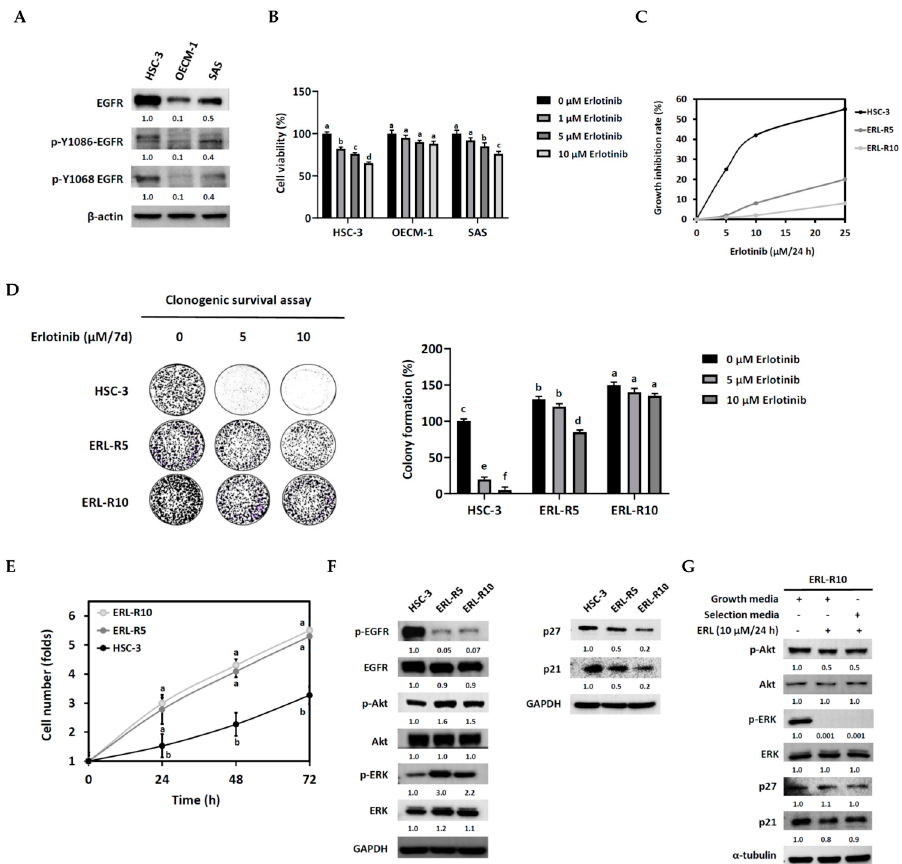
Figure 1. Establishment of erlotinib-resistant oral cancer cell lines. HSC-3, OECM-1, and SAS cells were cultured to 80% confluence, and ( A ) cell lysates were subjected to Western blot analysis to detect the protein levels of EGFR and p-EGFR. β -actin served as an internal control, and each protein expression level was quantified as a relative number to that of HSC-3 cells. ( B ) HSC-3, OECM-1, and SAS cells were cultured with or without erlotinib for 24 h, followed by an MTT cell viability assay. Each bar represented a cell number as a percentage of the control (0 µ M erlotinib). Values are mean ± SD, n = 3. abcd Values without the same letter differ significantly, p < 0.05. ( C – G ) Assessment of erlotinib-resistant cell lines. ( C ) HSC-3, ERL-R5, and ERL-R10 cells were cultured with erlotinib (0, 5, 10, 25 µ M) for 24 h and viable cell number was determined by an MTT assay. Data were expressed as growth inhibition rate relative to the control (0 µ M erlotinib). ( D ) HSC-3, ERL-R5, and ERL-R10 cells (2 × 10 3 cells) were seeded onto a 6-well plate and cultured with erlotinib (0, 5, 10 µ M) for 7 days and stained with 0.5% crystal violate. Each bar represented colony formation as a percentage of the control (0 µ M erlotinib). Values are mean ± SD, n = 3. abcdef Values with different letter differ significantly, p < 0.05. ( E ) HSC-3, ERL-R5, and ERL-R10 cells (1.5 × 10 4 cells) were cultured in 3-cm dishes for 24 h and viable cell number was determined by an MTT assay. Values are mean ± SD, n = 3. ab Values with different letter differ significantly at indicated time point, p < 0.05. ( F ) Cell lysates from HSC-3, ERL-R5, and ERL-R10 cells with 80% confluence were subjected to Western blot analysis for indicated proteins. ( G ) ERL-10 cells were cultured in growth media with or without erlotinib or in selection media to 80% confluence, and cell lysates were collected to determine indicated proteins by Western blot analysis. Each protein band was quantified as a relative number to that of ERL-10 cells in growth